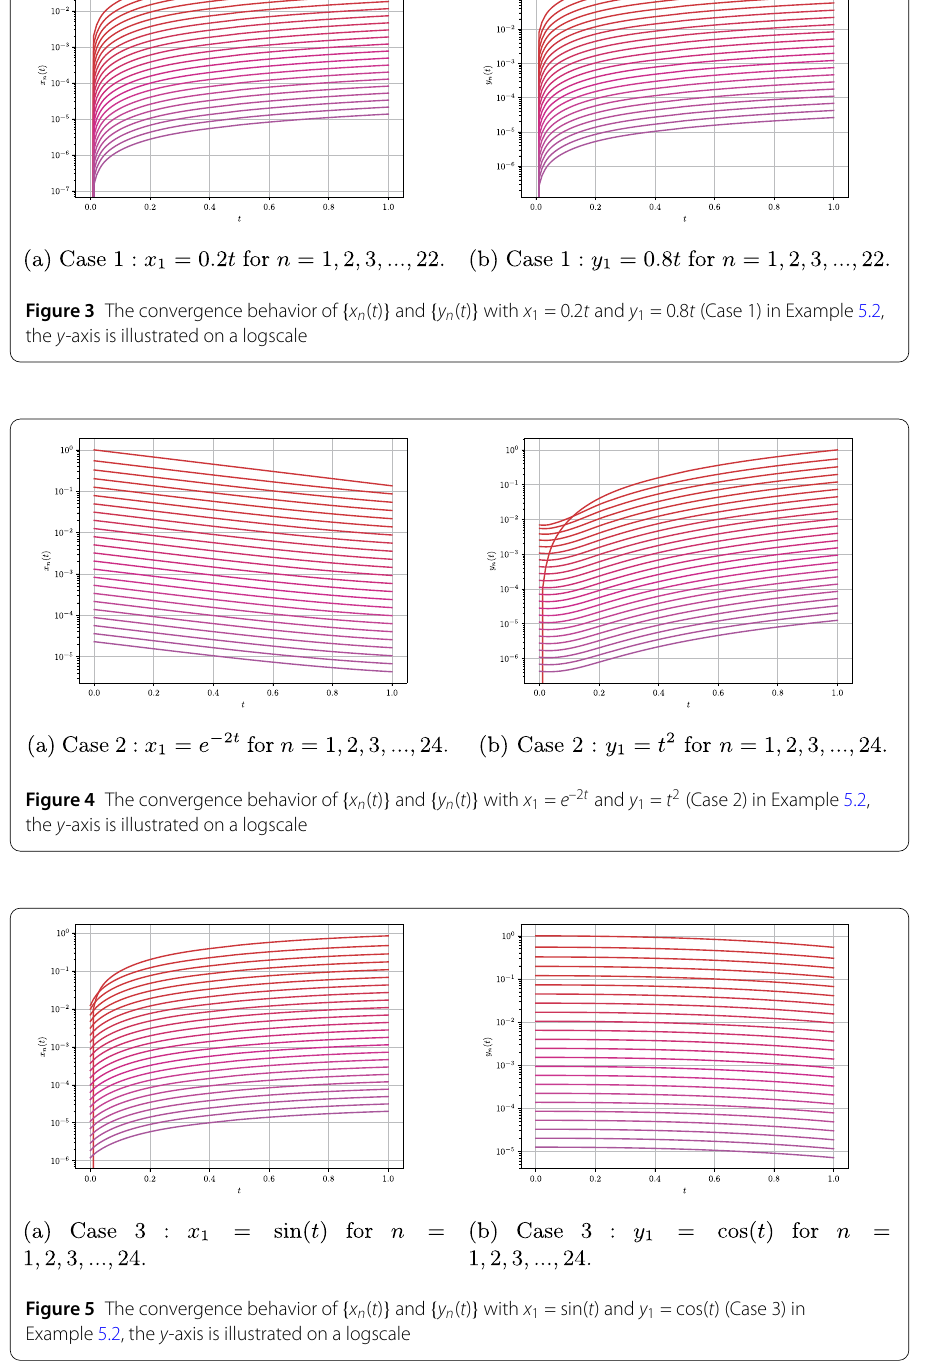
The comparison of Algorithm (5.3) and Algorithm (5.4), which is modified from Algo- rithm 3.2 in [6], in terms of the CPU time and the number of iterations with different starting points, is reported in Table